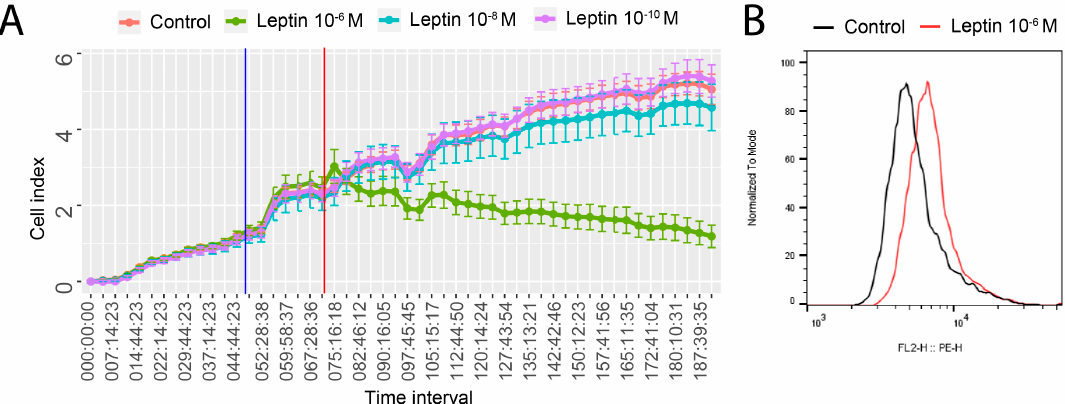
Figure 1. ( A ) Cell index values of LNCaP cells cultivated for 196 h in the presence of various LEP concentrations. Electrical impedance is measured throughout the cultivation period at a 15-minutes frequency. The time point of the medium changed to starvation medium is marked with a blue vertical line. LEP is provided at the time point indicated by a red vertical line. The mean cell index values with SE for the eight repetitions in each group are shown. ( B ) Flow cytometry analysis of Cleaved PARP-1. Median fluorescence intensity, LNCaP cells treated with LEP (1 × 10 − 6 M) in relation to untreated control group.